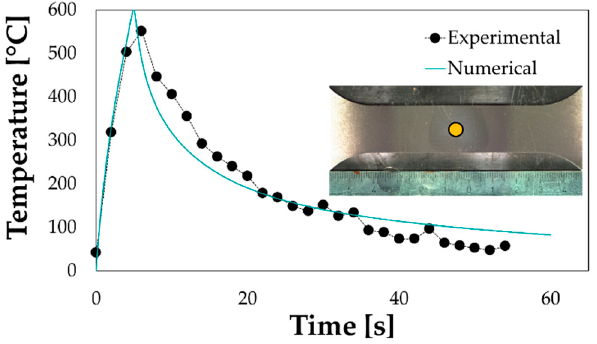
Figure 13. Tuning of the FE thermal model (the detailed view of the treated specimen is also reported).